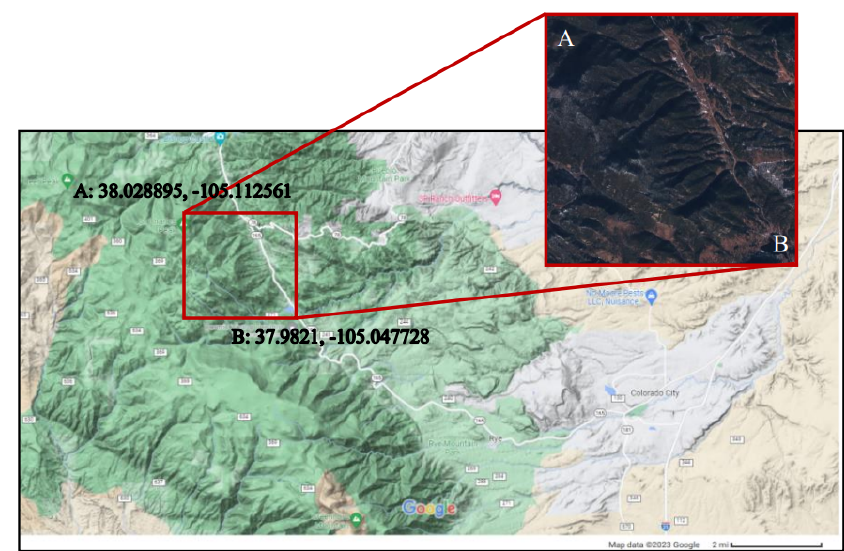
Figure 1. Study area latitude and longitude GPS coordinates in decimal degrees (DD).